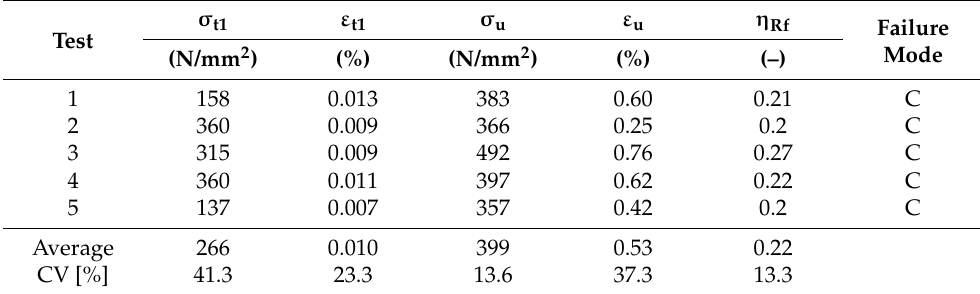
Figure 7. C-CTF test results: ( a ) stress–strain curves; ( b ) crack pattern; ( c ) specimens after the test. Table 7. C-CTF test results.